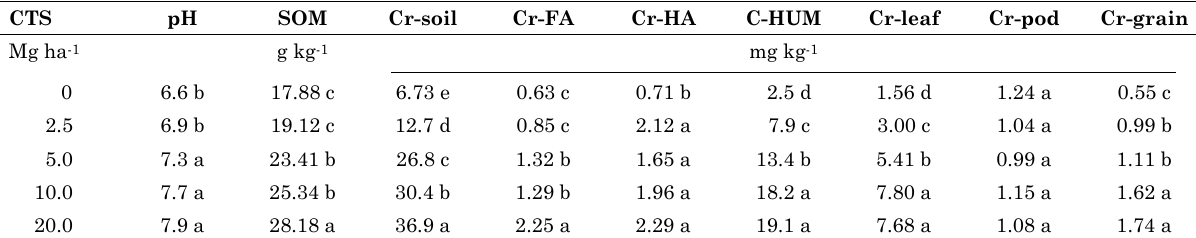
Table 3. pH values, soil organic matter (SOM), and Cr in the soil, fulvic acids (Cr-FA), humic acids (Cr-HA), and humin (Cr-HUM) fractions and chromium concentration in leaves, pods, and grains of cowpea after four years of composted tannery sludge (CTS) application CTS pH